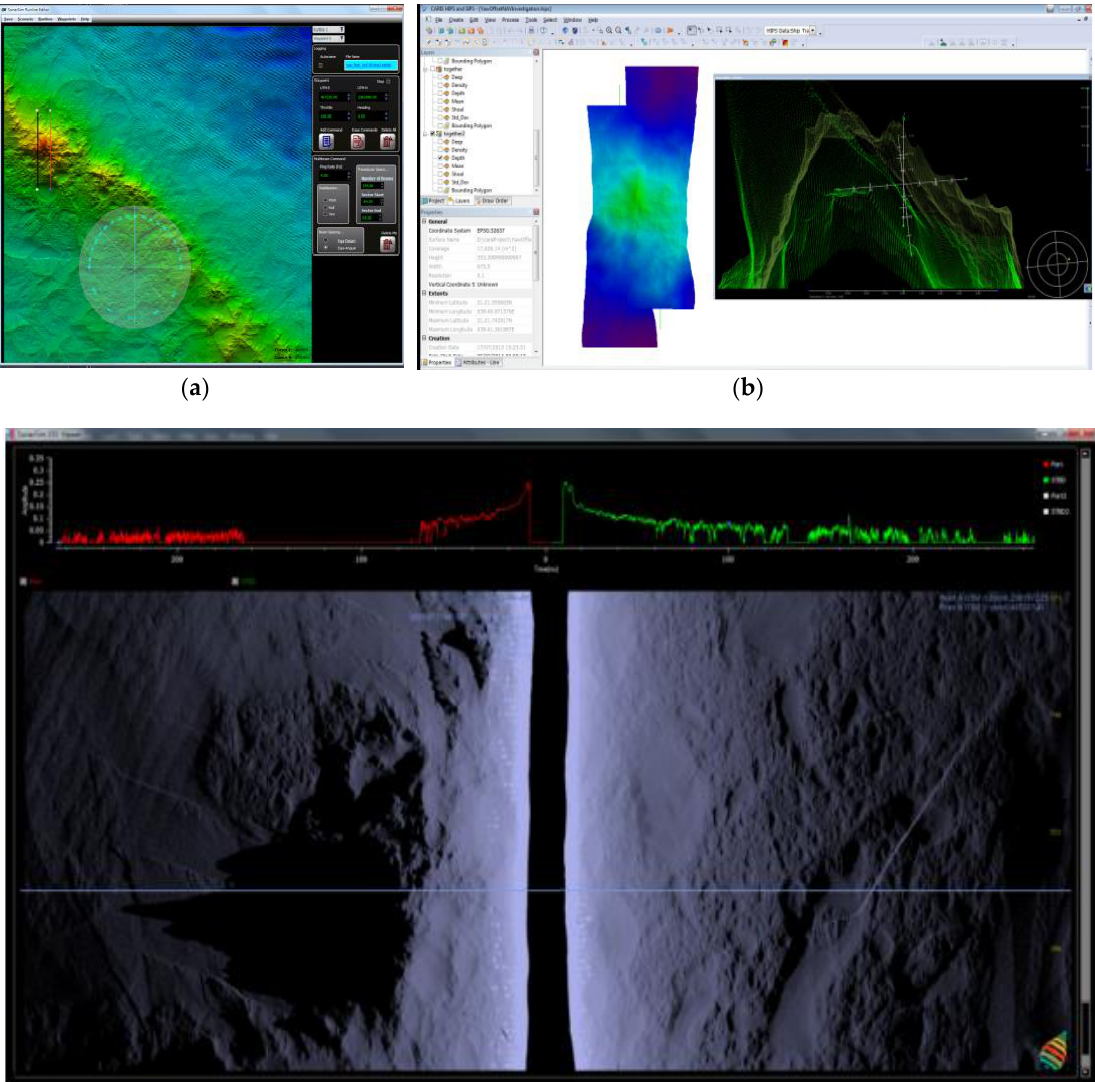
Figure 3. ( a ) Simulation mission planner showing two runlines passing over a ridge feature. ( b ) The